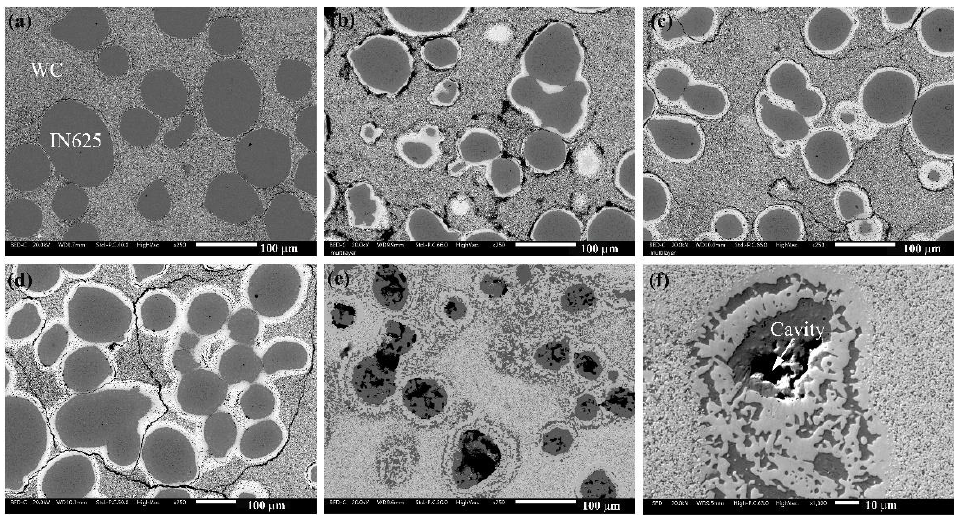
Figure 2. WC–IN625 microstructure of the pre-compacted ( a ), and sintered specimens at 1250 °C ( b ), 1275 °C ( c ), 1300 °C ( d ),1350 °C ( e ) and ( f ).